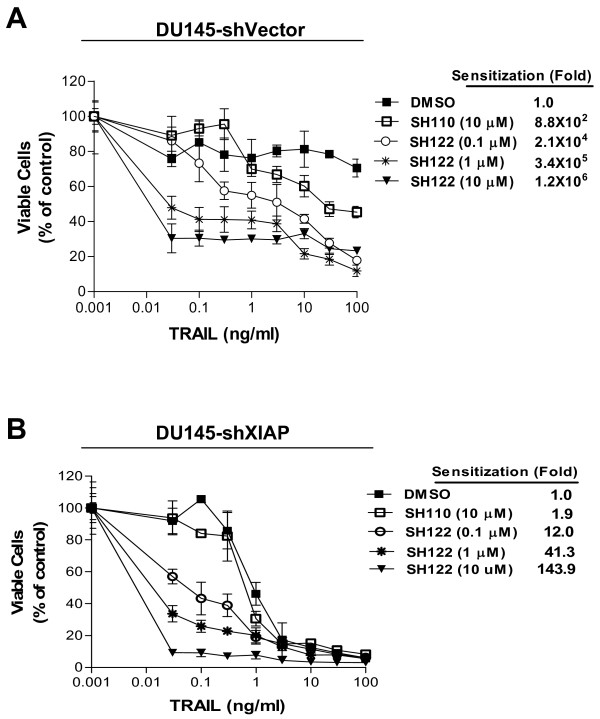
Downregulation of XIAP attenuated sensitization effect of SH122 on TRAIL-induced cell death. Cells transfected with either XIAP shRNA (A) or the vector control shRNA (B) were treated with serial diluted TRAIL, alone or in combination with 0.1, 1 and 10 μM of SH122, respectively, with 10 μM of SH110 as a negative control. Cytotoxicity was determined by CCK-8 detection kit. Normalized data were presented as mean ± SD (n = 3). Fold of sensitization was calculated by dividing IC50 of the compound-treated group by that of DMSO control.